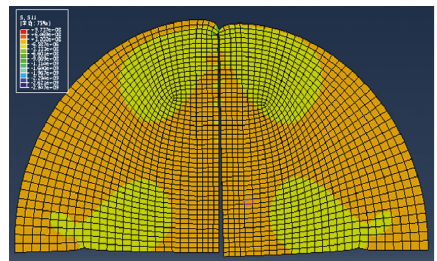
Figure 7: Crack propagation from XFEM.